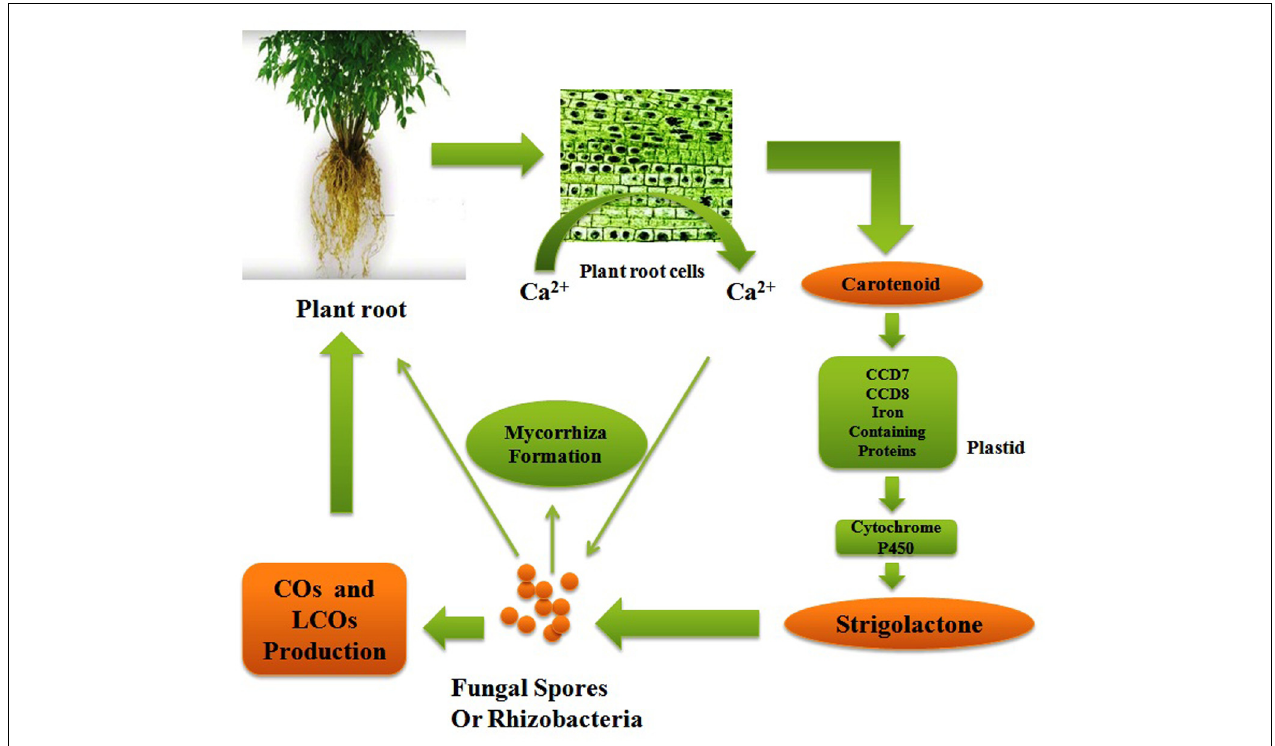
FIGURE 3 | A Signal communication system between plant root and arbuscular